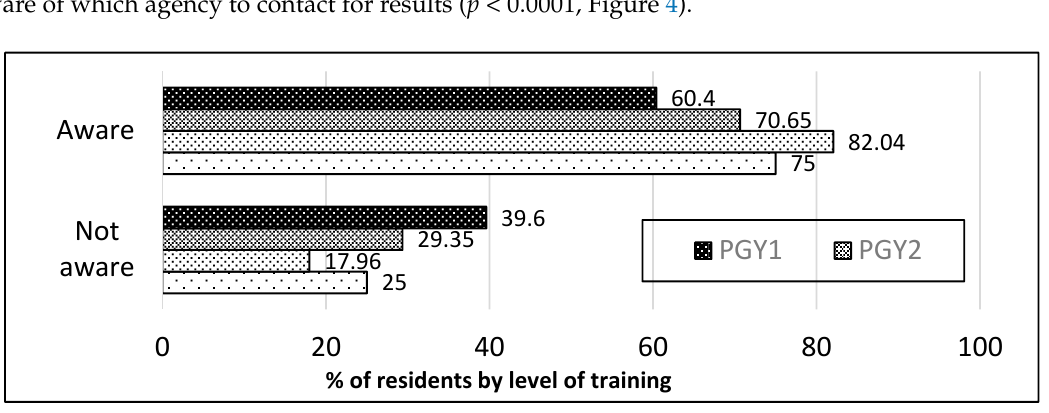
Figure 4. Awareness of agency to contact for NBS results by training level. Higher level RES (PGY3 + PGY4) are most likely to be aware compared to lower level RES (PGY1 + PGY2); ( p < 0.0001).